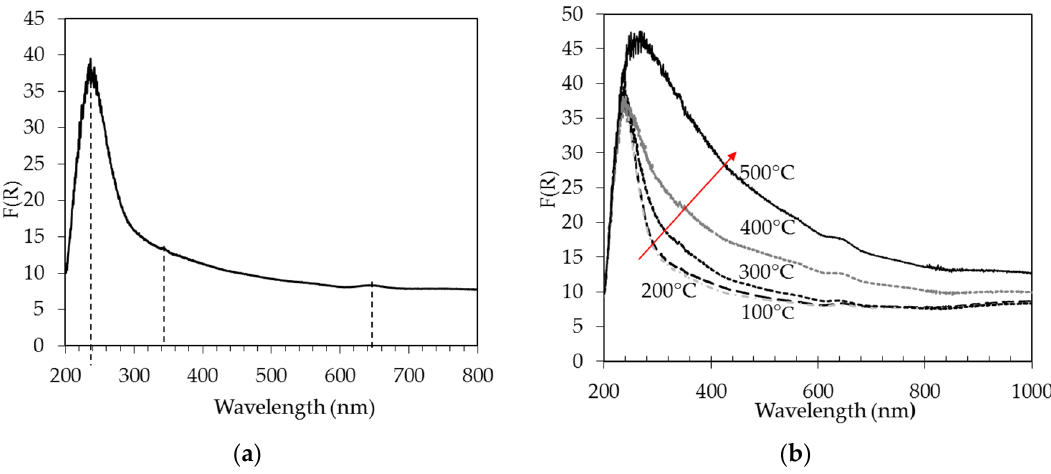
Figure 5. In situ UV–Vis spectrum of: ( a ) 0.4Pt/AW catalyst calcined at 500 °C; ( b ) 0.4Pt/AW catalyst during the reduction process with 5 vol.% H 2 /N 2 , 0.5 cm 3 /s.